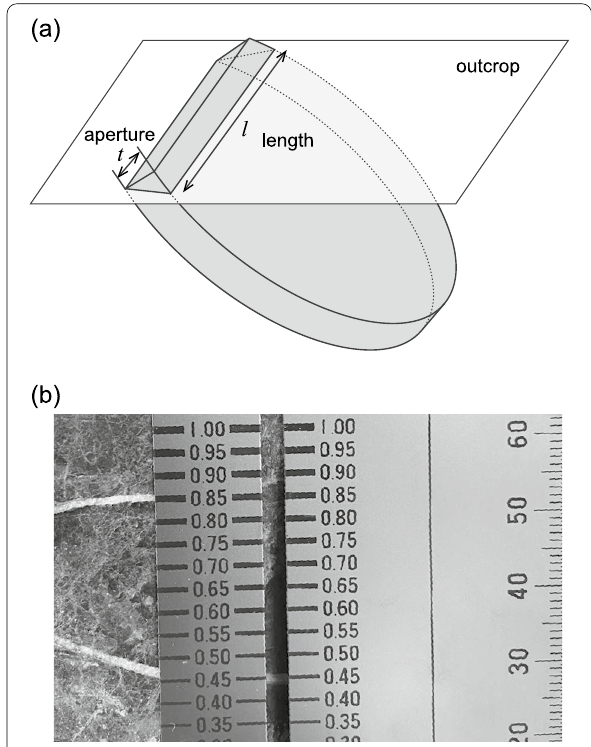
Fig. 3 a Schematic illustration of the part of a vein measured in the study. b Measurement of the aperture of vein using a crack width ruler. Here, the aperture of vein is 0.85